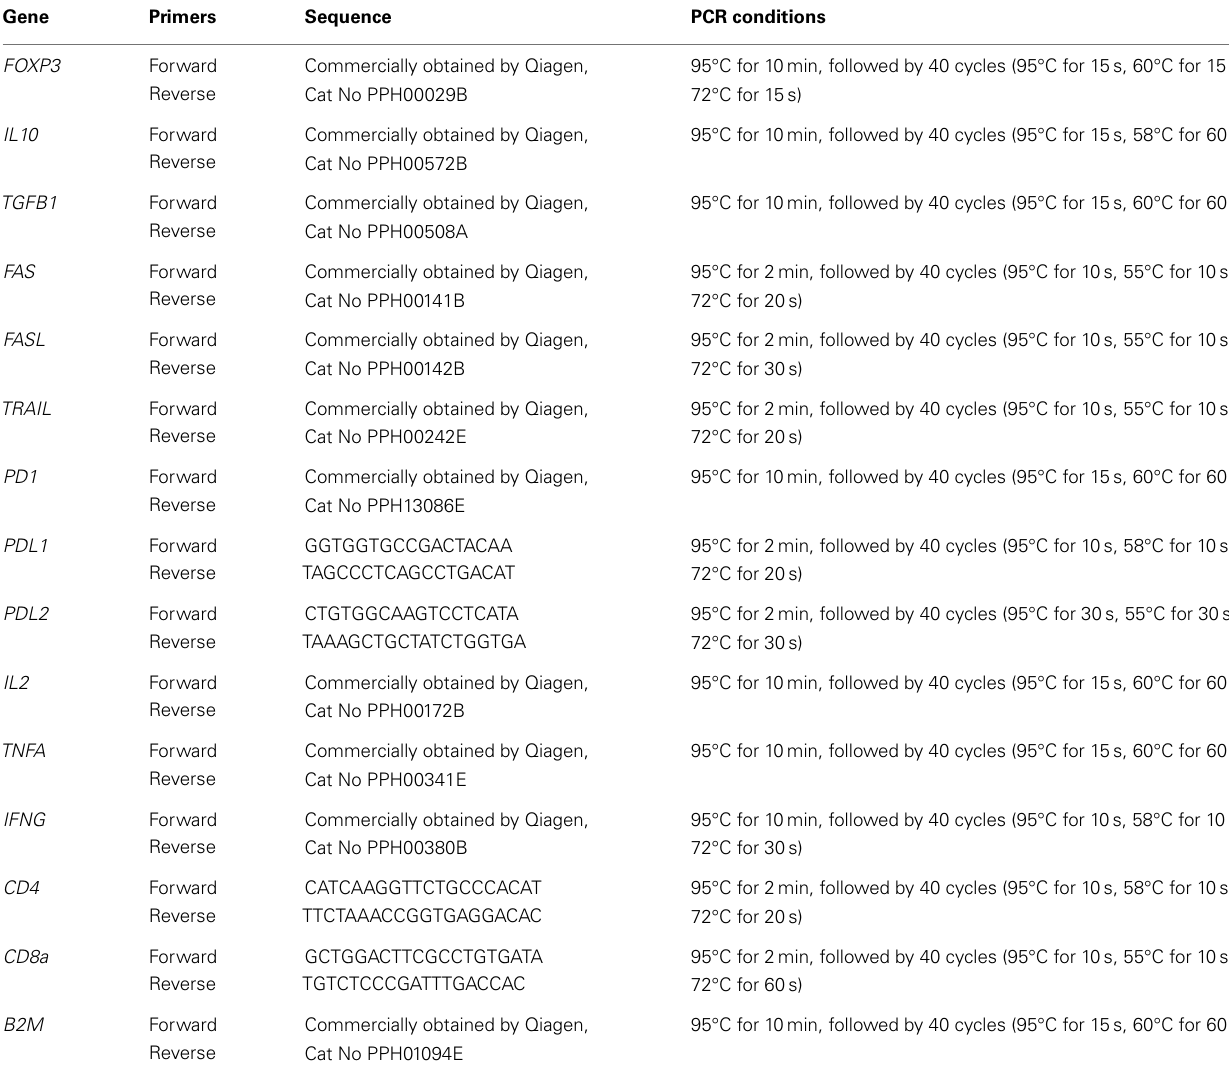
Table 2 | Primers and PCR conditions for the amplification of the analyzed genes.